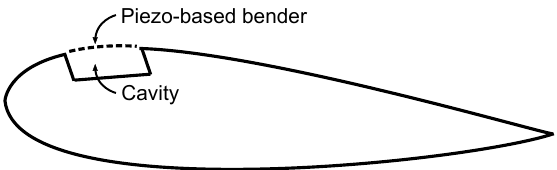
Figure 5. Example of geometric actuator using piezo-based